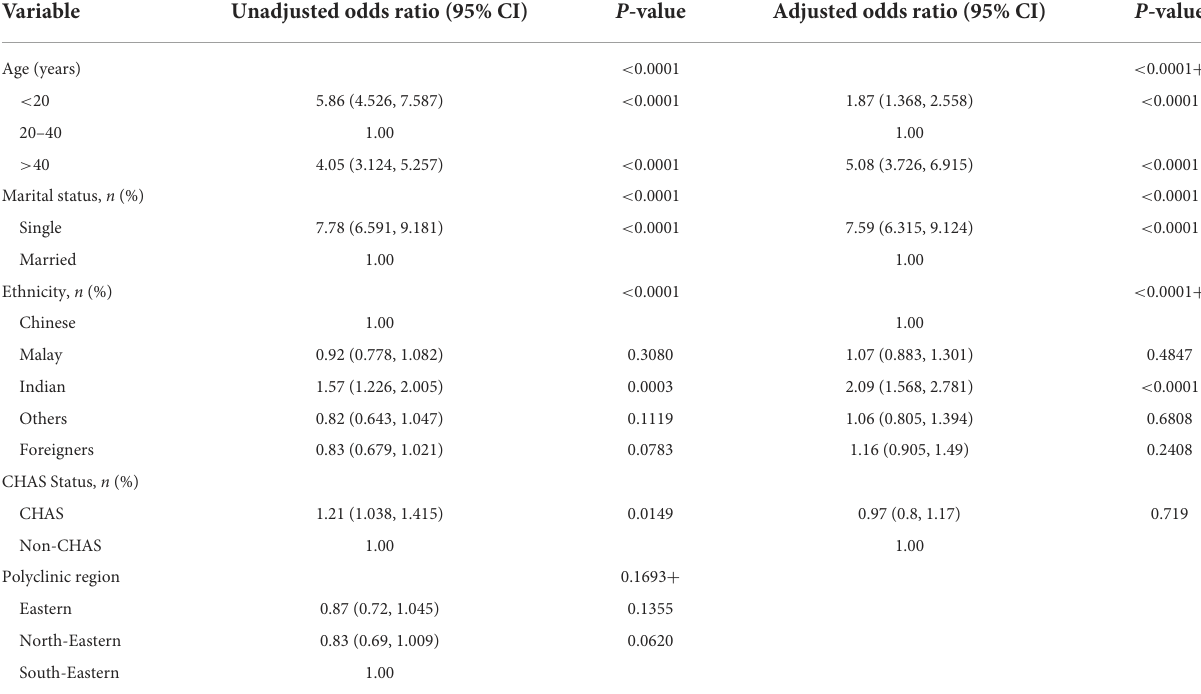
TABLE 2 Univariate and multivariable logistic regression analysis to find associated risk factors for referral requests for unintended pregnancy. Variable